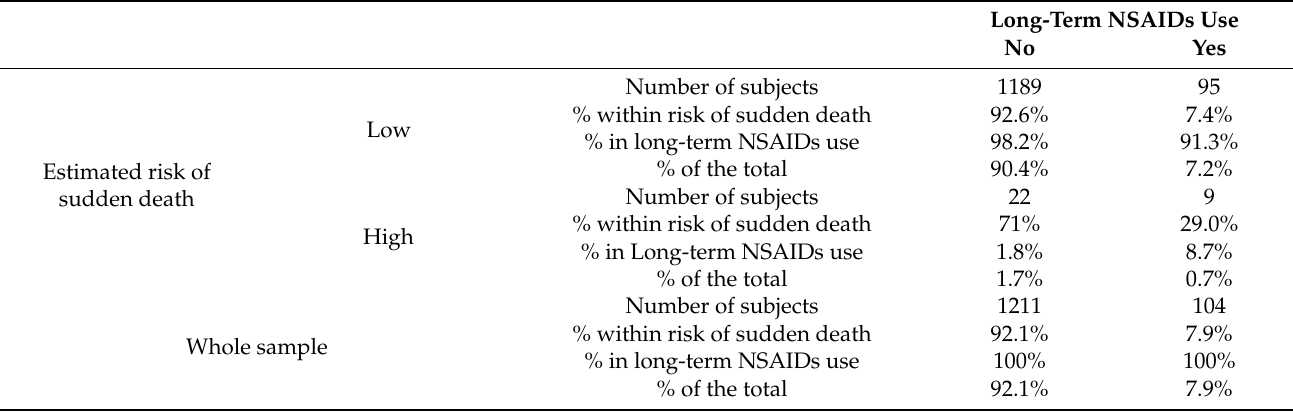
Table 1. Contingency table about non-steroid anti-inflammatory drugs (NSAIDs) use in the 2016 Brisighella Heart Study (BHS) survey subpopulations, according to the ECG risk score.